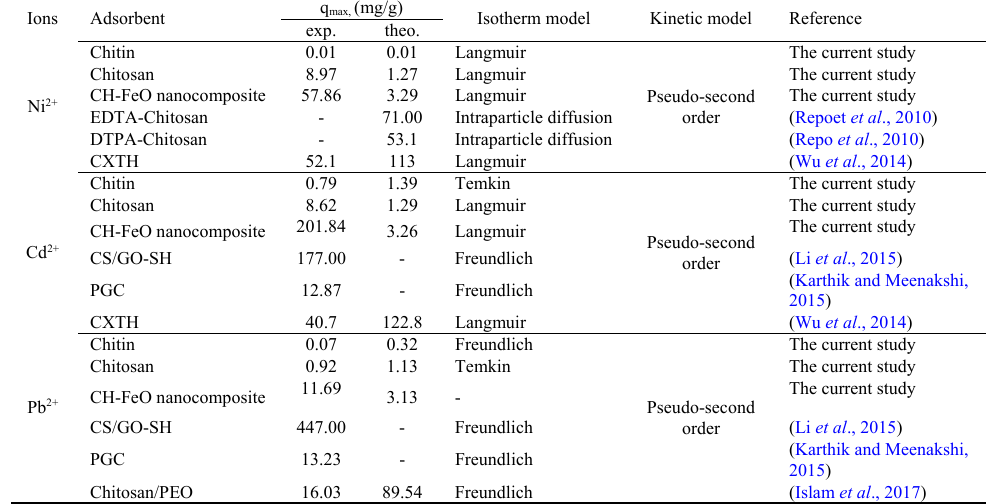
Table 4: Comparison of the studied adsorbents and other different adsorbents for removal of Ni 2+ , Cd 2+ and Pb 2+ ions